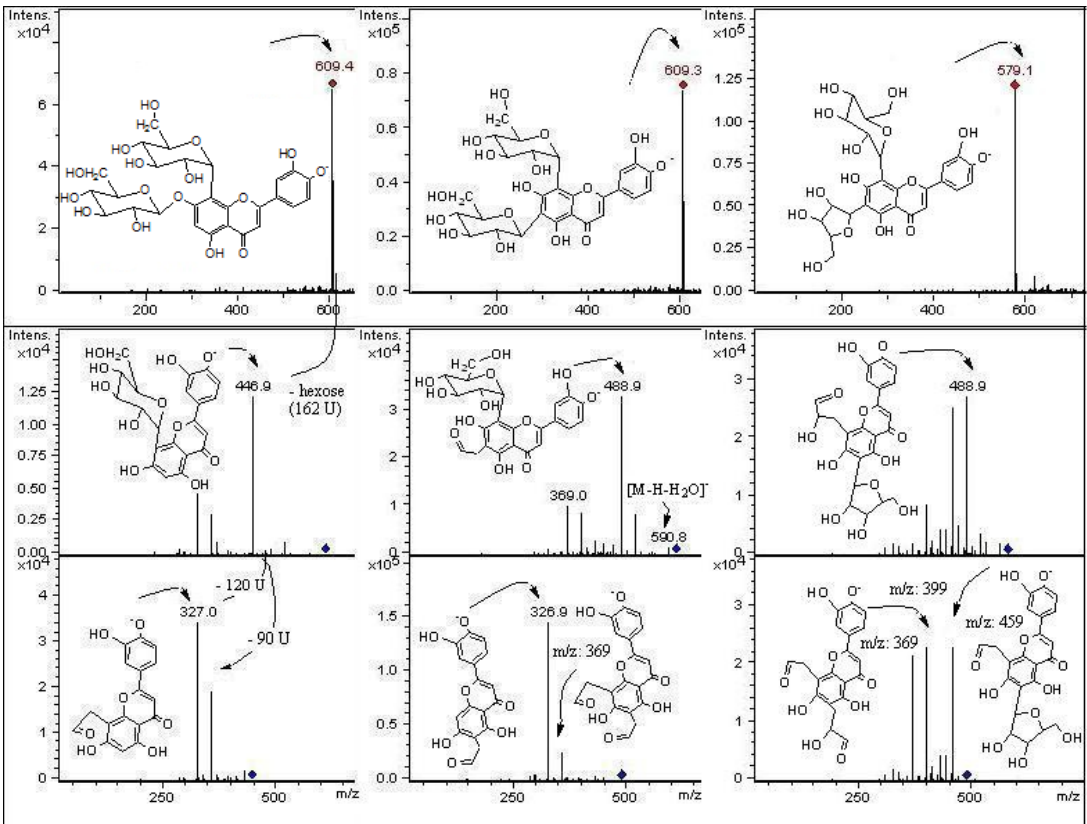
Figure 6. Structures, fragmentation, full ESI-MS and MS-MS spectra of peaks 3, 5 and 8.